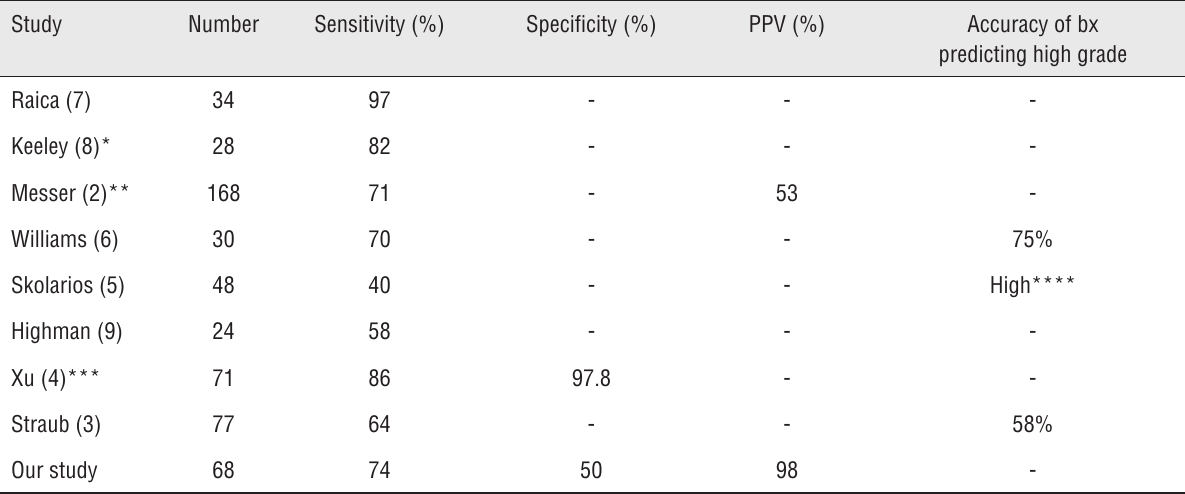
Table 4 - Summary of published